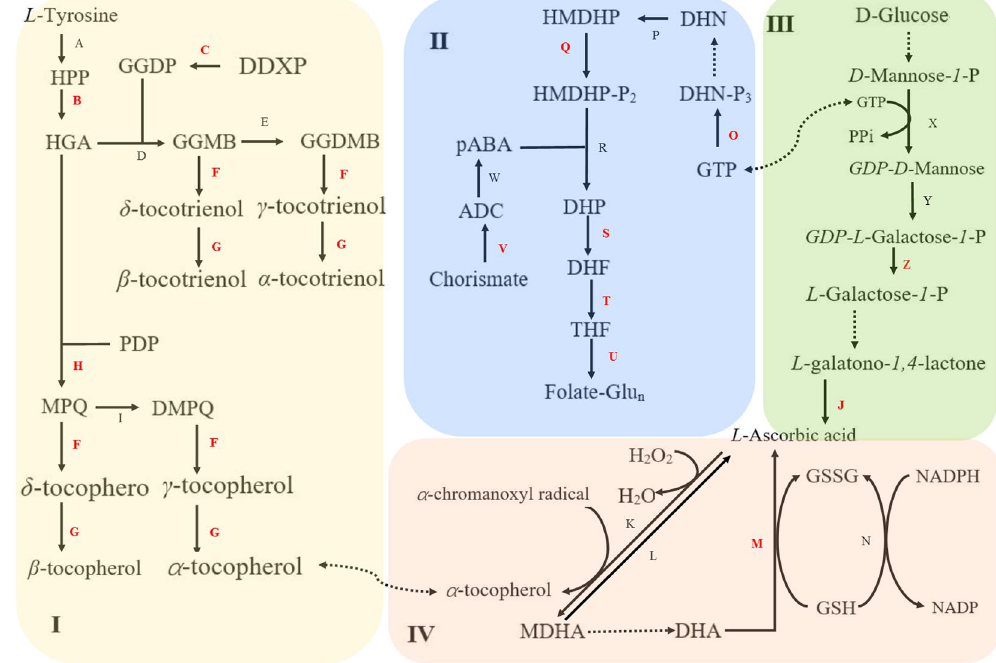
Figure 1. Pathways investigated in this study. (I) Vitamin E biosynthesis pathway. (II) Folate biosynthesis pathway. (III) Vitamin C biosynthesis pathway. (IV) Ascorbic acid-Glutathione-Tocopherol cycle. Letters indicates the catalyzing enzymes in the individual reactions and red letters refers to those enzymes studied in this paper: A, tyrosine aminotransferase; B, HPPD, 4-hydoxyphenyl-pruvate dioxygenase; C, DXPR, 1-deoxy-D-xylulose-5-phosphate reductase; D, HGGT, homogentisate geranylgeranyl transferase; E, I, MPBQ-MT, 2-methyl-6-phytyl-1,4-benzoquinol methyltransferase; F, TC, tocopherol/tocotrienol cyclase; G, TMT, tocopherol/tocotrienol methyltransferase; H, HPT, homogentisic acid phytyltransferase; J, GLDH, L-galactono-1,4-lactone dehydrogenase; K, APX, ascorbate peroxidase; L, MDHAR, monodehydroascorbate reductase; M, DHAR, dehydroascorbate reductase; N, GR, glutathione reductase; O, GTPCH, GTP cyclohydrolase; P, DHN aldolase; Q, HPPK, 6-hydroxymethyldihydropterin pyrophosphokinase; R, DHPS, dihydropteroate synthase; S, DHFS, dihydrofolate synthase; T, DHFR, dihydrofolate reductase; U, FPGS, folylpolyglutamate synthase; V, ADCS, aminodeoxychorismate synthase; W, aminodeoxychorismate lyase; X, GMP, GDP-mannose pyrophosphorylase; Y, GME, GDP-mannose-3,5-epimerase; Z, VTC2, GDP-L-galactose phosphorylase. Abbreviations: HPP, 4-hydoxyphenyl-pyruvate; HGA, homogentisic acid; GGDP, geranylgeranyl diphosphate; DDXP, 1-deoxy-D-xylulose-5-p; GGMB, 6-geranylgeranyl-2-methylbenzene-1,4-diol; GGDMB, geranylgeranyl-2,3-dimethylbenzene-1,4-diol; PDP, phytyldiphosphate; MPQ, 1-methyl-6-phytyl-1,4- benzoquinol; DMPQ, 2,3-dimenthyl-5-phytyl-1,4-benzoquinol; MDHA, monodehydroascorbate; DHA, dehydroascorbate; GSH, glutathione; GSSG, oxidized glutathione; NADP, nicotinamide adenine dinucleotide phosphate; NADPH, nicotinamide adenine dinucleotide phosphate; GTP, guanosine triphosphate; DHN-P, dihydroneopterin phosphate; DHN, dihydroneopterin; HMDHP, 6-hydroxymethyldihydropterin; HMDHP-P 2 , 6-hydroxymethyldihydropterin diphosphate; DHP, dihydropteroate; DHF, dihydrofolate; THF, tetrahydrofolate; ADC, aminodeoxychorismate; pABA,